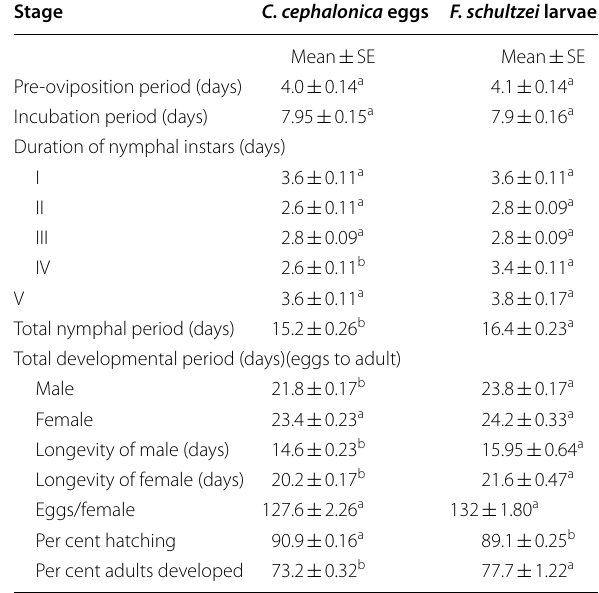
Table 1 Biology of Dortus primarius on tomato plant fed with Corcyra cephalonica eggs and Frankliniella schultzei larvae. In row means with different letters are significantly different with each other (Mann- Whitney U test; P <